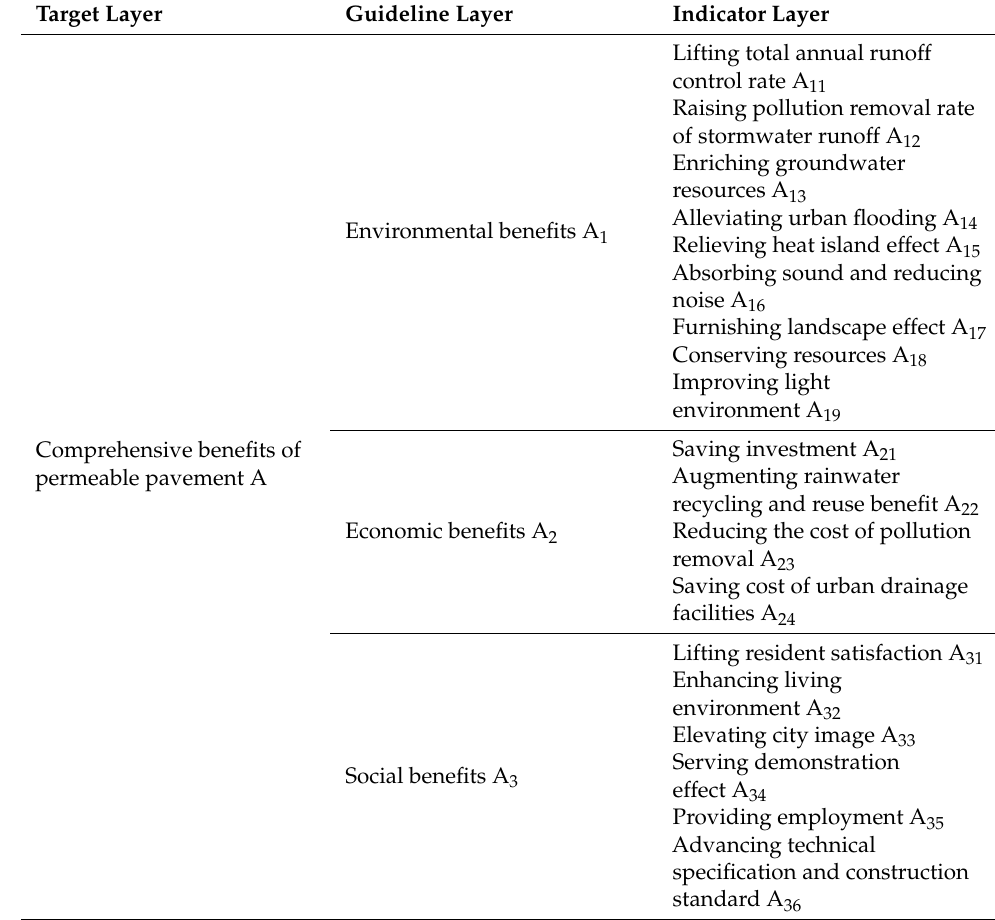
Table 1. The hierarchical structure of the comprehensive benefit evaluation indicators for perme- able